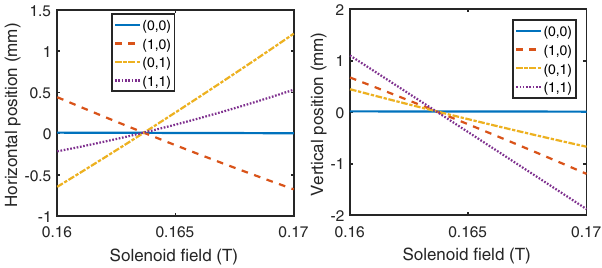
FIG. 2. The variation of beam position on the observation screen versus solenoid field is simulated by the ASTRA code. The legend contains the particles ’ initial transverse position on the cathode with a unit of